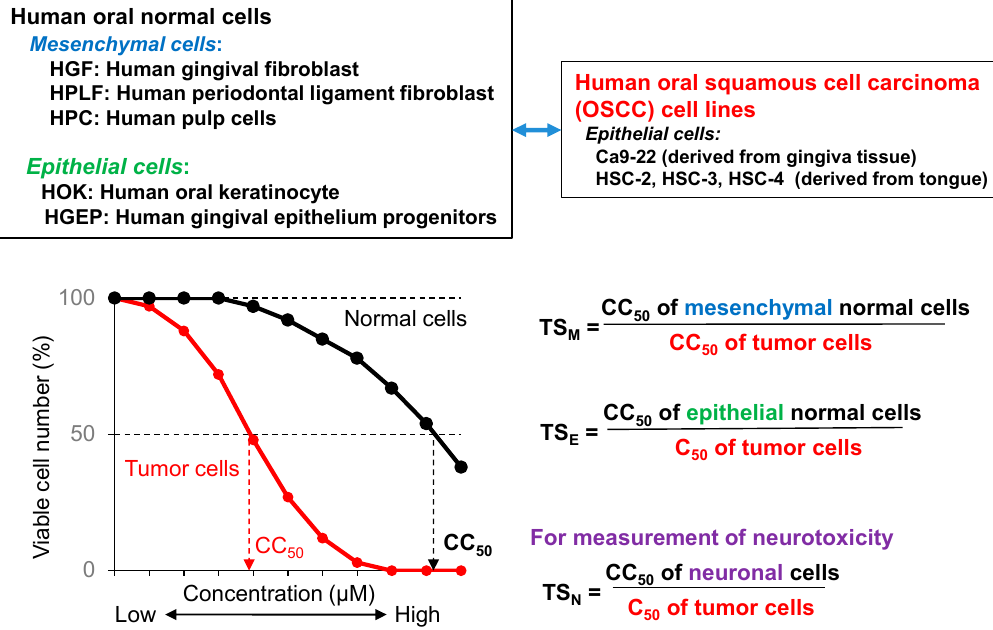
Figure 2. In vitro assay system for the measurement of tumor specificity.